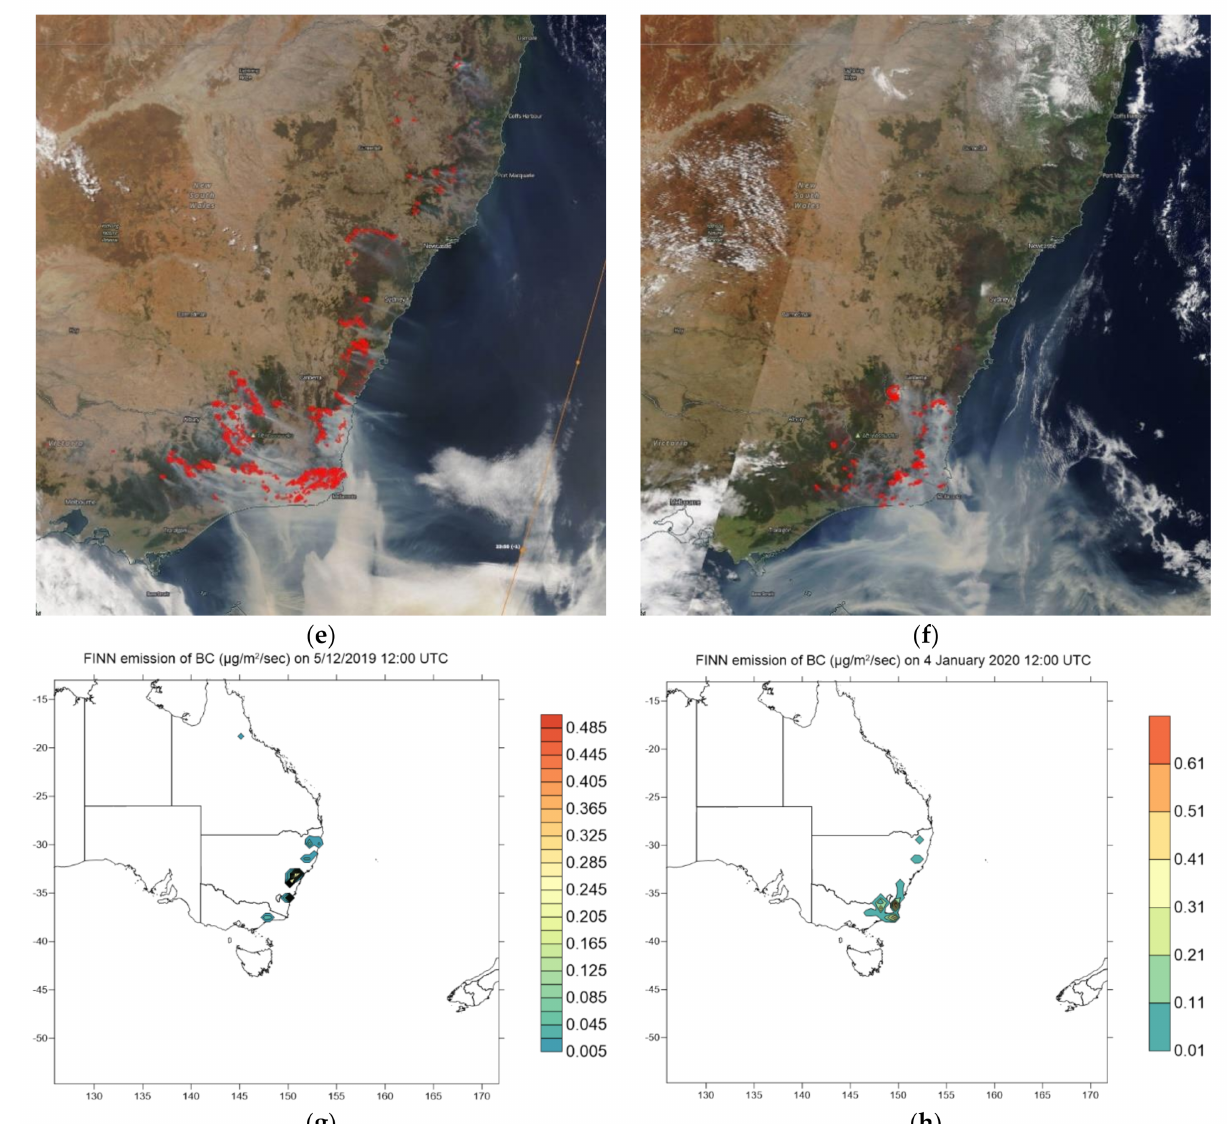
Figure 4. Fires started in northern NSW and the Blue Mountains (northwest of Sydney) as seen by the MODIS Aqua/Terra satellite on 6 November 2019 ( a ) and 7 November 2019 ( b ). From early December to the end of the month, fires were more intense in the Blue Mountains and the south coast: 5 December 2019 ( c ), 18 December 2019 ( d ). By early January, fires were mainly in the south coast and the border region with Victoria on 4 January 2020 ( e ) and the East Gippsland (Victoria) toward the end of January 31 January 2020 ( f ). Emission of BC (black carbon) as a marker of wildfires from the FINN on 5 December 2019, 12:00 UTC, ( g ) and on 4 January 2020, 12:00 UTC ( h